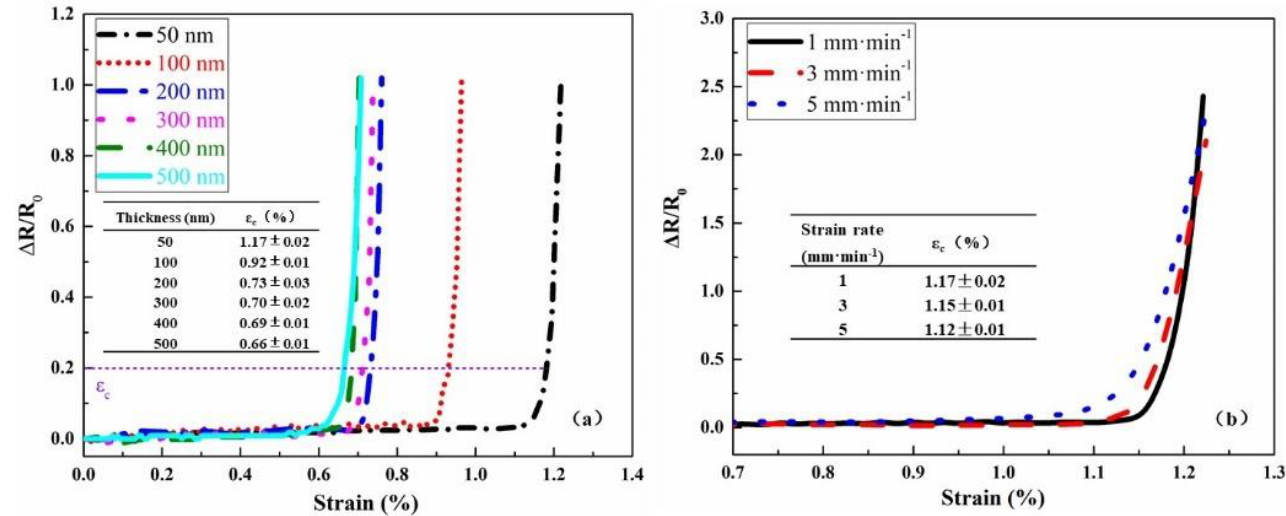
Figure 1. ( a ) Fractional change in resistance ( ∆ R/R 0 ) of ITO with different thicknesses deposited on PC as a function of strain ε ; ( b ) ∆ R/R 0 ~ ε curve of ITO with 500 nm thickness deposited on PC under different strain rates. R 0 denoted the electrical resistance of the unloaded ITO thin film.